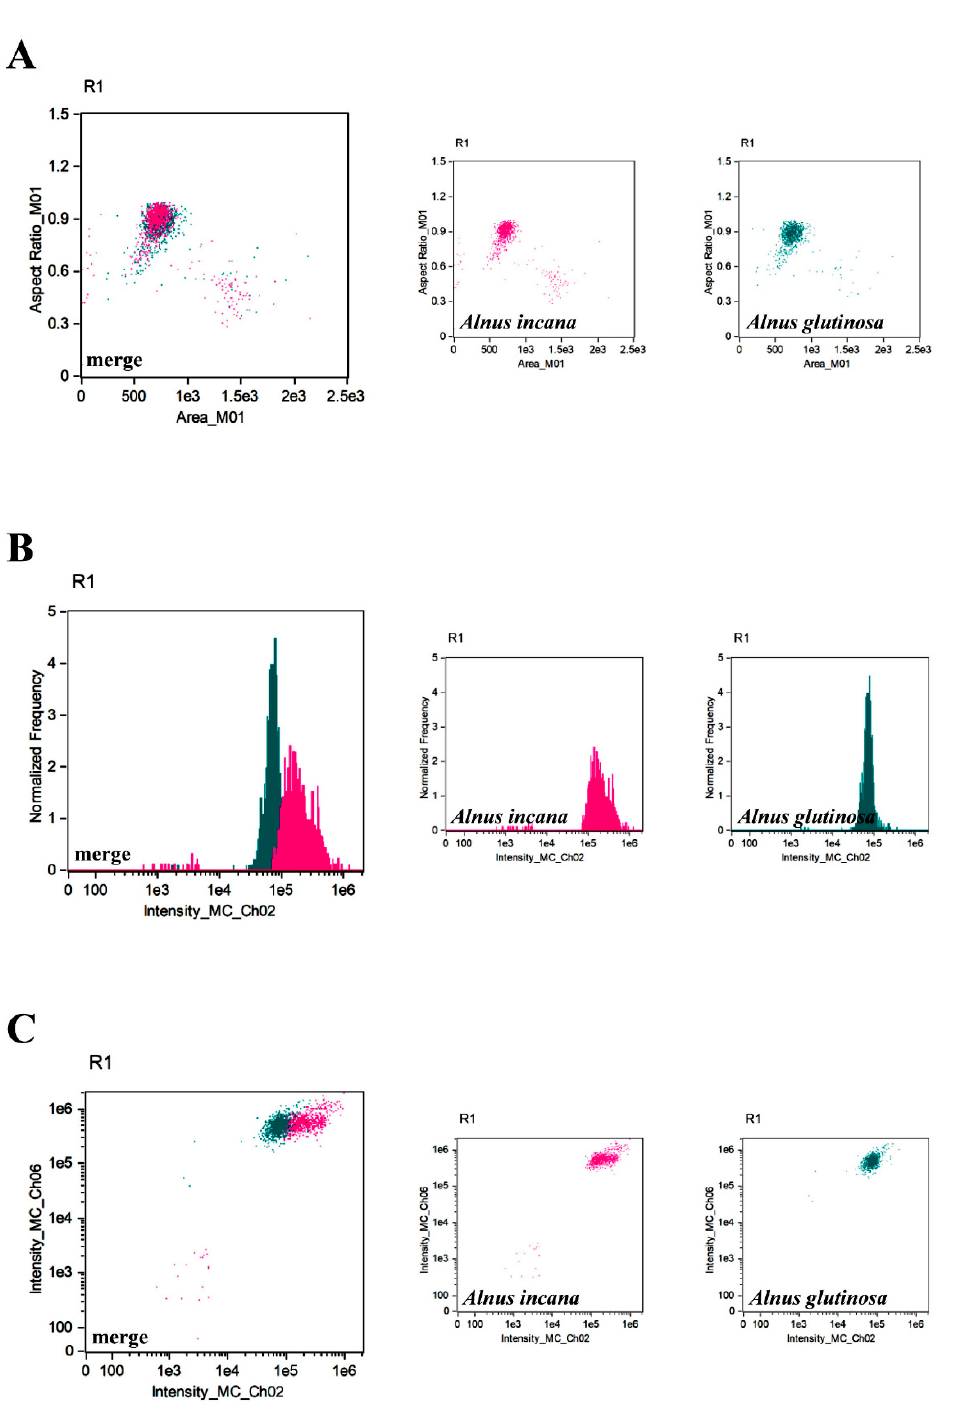
Figure 4. Characterisation of pollen grains populations of two species of alder: Alnus incana (pink) and Alnus glutinosa (teal) using IFC. Three types of analysis (different parameters) were considered, namely ‘aspect ratio’ parameter in channel 1 (BF, y -axis) versus ‘area’ parameter (channel 1, BF, x -axis) ( A ), ‘normalized frequency’ parameter (channel 1, BF, y -axis) versus fluorescence ‘intensity’ parameter in channel 2 ( x -axis) ( B ) and the fluorescence ‘intensity’ parameter (channel 6, SSC, y -axis) versus fluorescence ‘intensity’ parameter (channel 2, x -axis) ( C ). Separate tree profiles and merged profiles are shown.